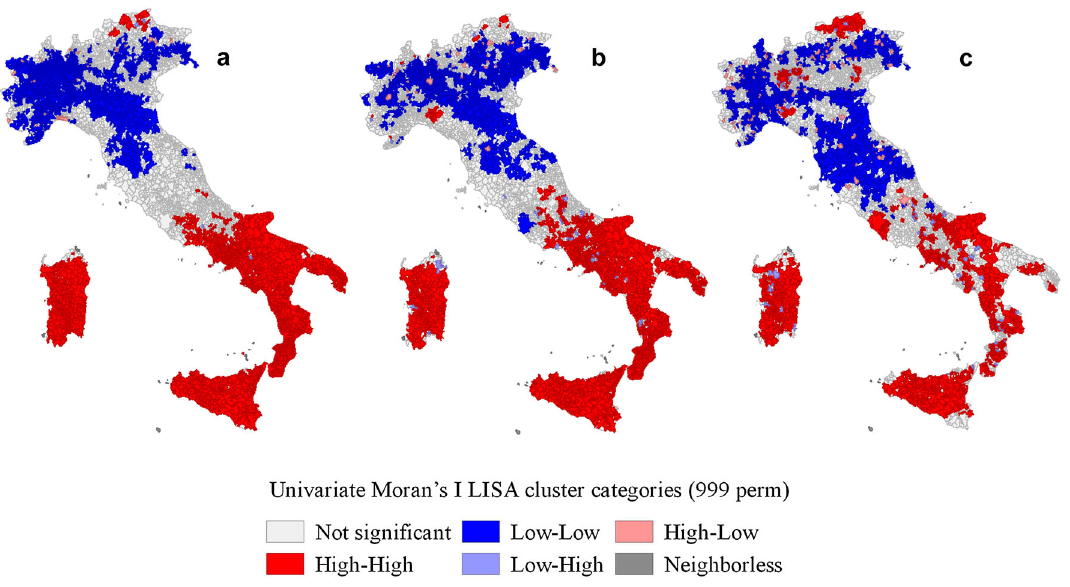
test statistic was assessed with a Monte Carlo P value generated using 999 random permutations